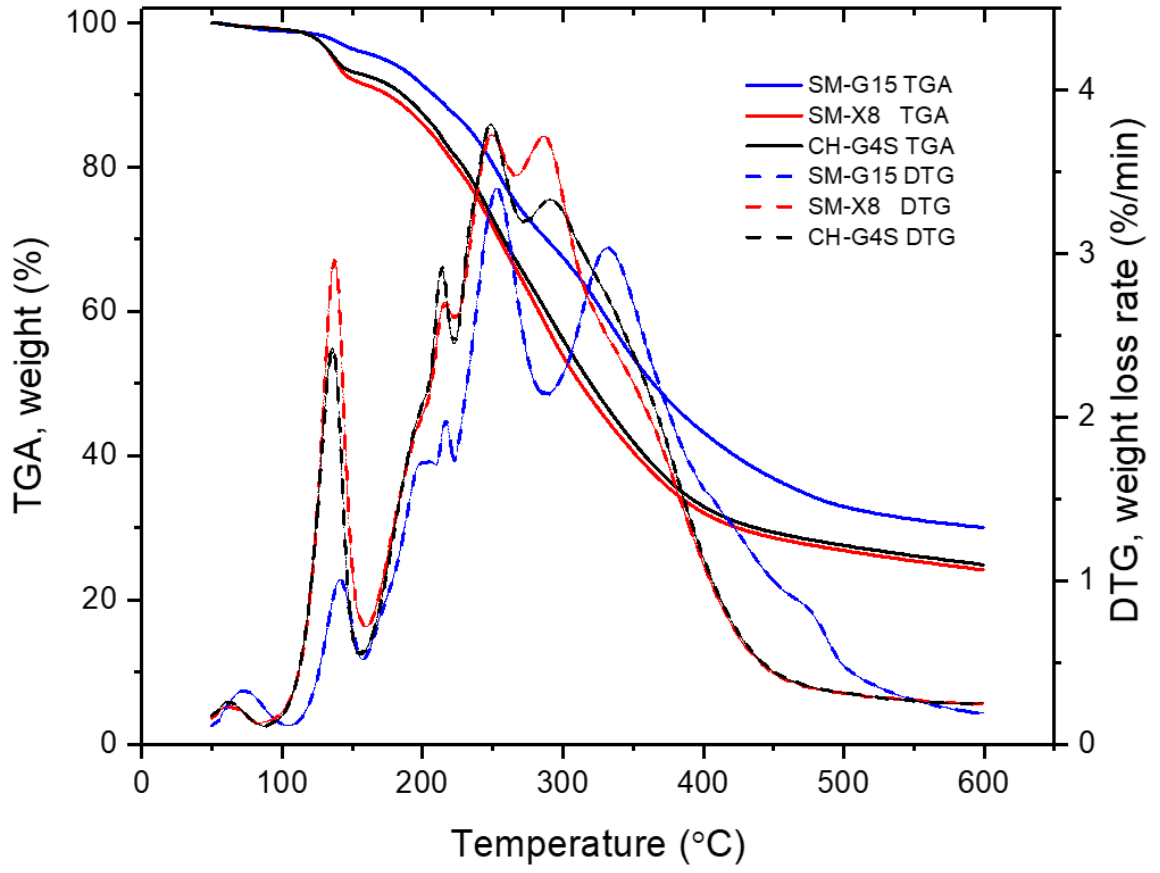
Figure 9. Thermogravimetric (solid lines) and derivative thermogravimetric (dashed lines) curves resulting from the TGA analysis of EPS produced by cultivation of B. atrophaeus BU4 in glucose- (SM-G15) and xylose-based (SM-X8) synthetic media, and in a quinoa stalk cellulosic hydrolysate